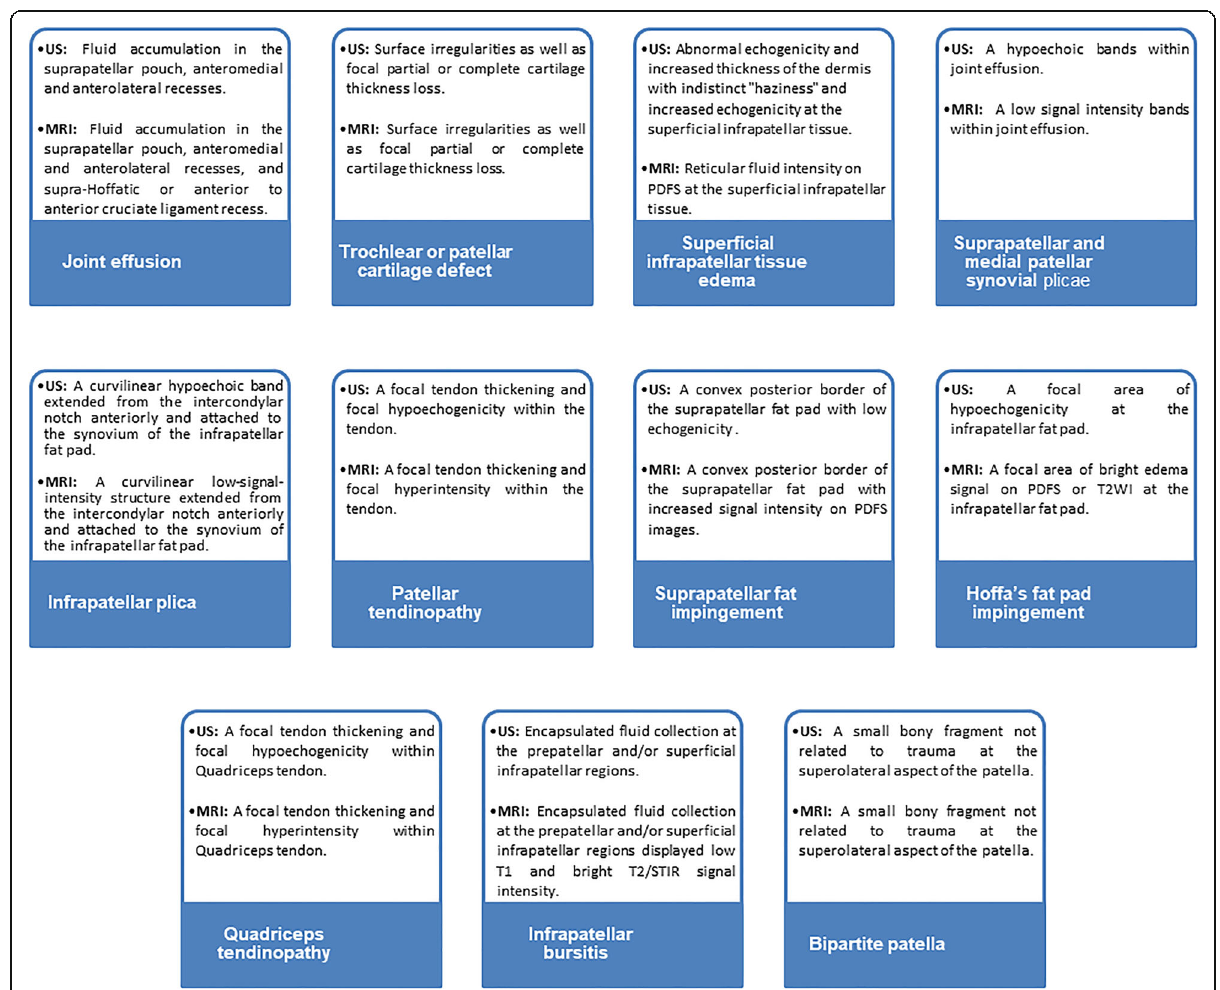
Fig. 2 Ultrasonography and MRI findings of AKP. US, ultrasonography; MRI, magnetic resonance imaging; AKP, anterior knee pain; PDFS, proton density fat sat; STIR, short tau inversion recovery